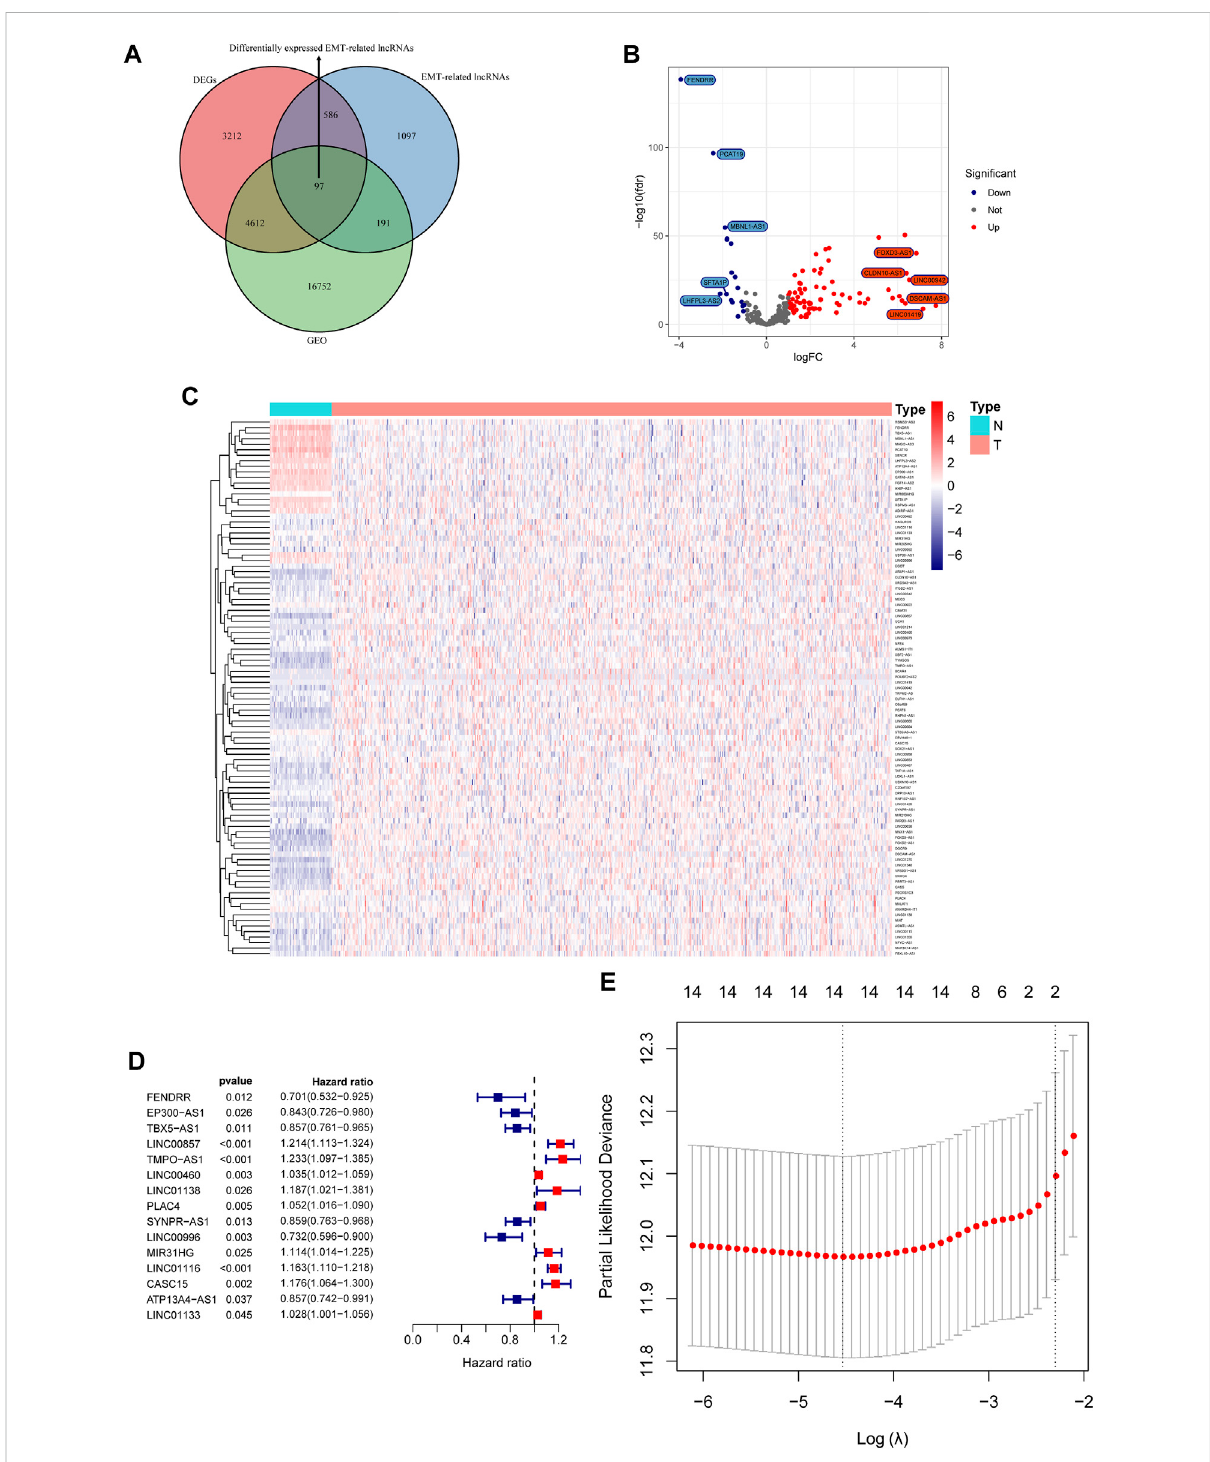
FIGURE 1 Construction of a prognostic signature based on the expression of EMT-related lncRNAs. (A) Venn diagram of differentially expressed EMT- relatedlncRNAsinGEOandTCGAcohorts. (B) VolcanoplotofdifferentiallyexpressedEMT-relatedlncRNAs. (C) Heatmapofdifferentiallyexpressed EMT-lncRNAs. (D) Forest plot of prognostic EMT-related lncRNAs. (E) Identi fi cation of key prognostic EMT-related lncRNAs via variable selection in LASSO Cox